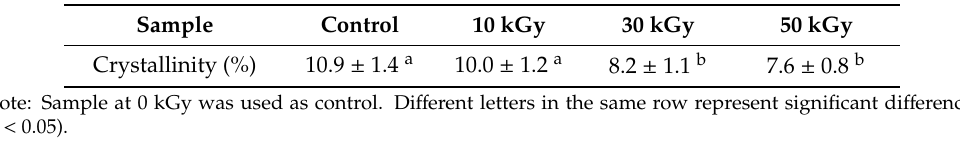
Table 3. Starch crystallinity of corn after EBI